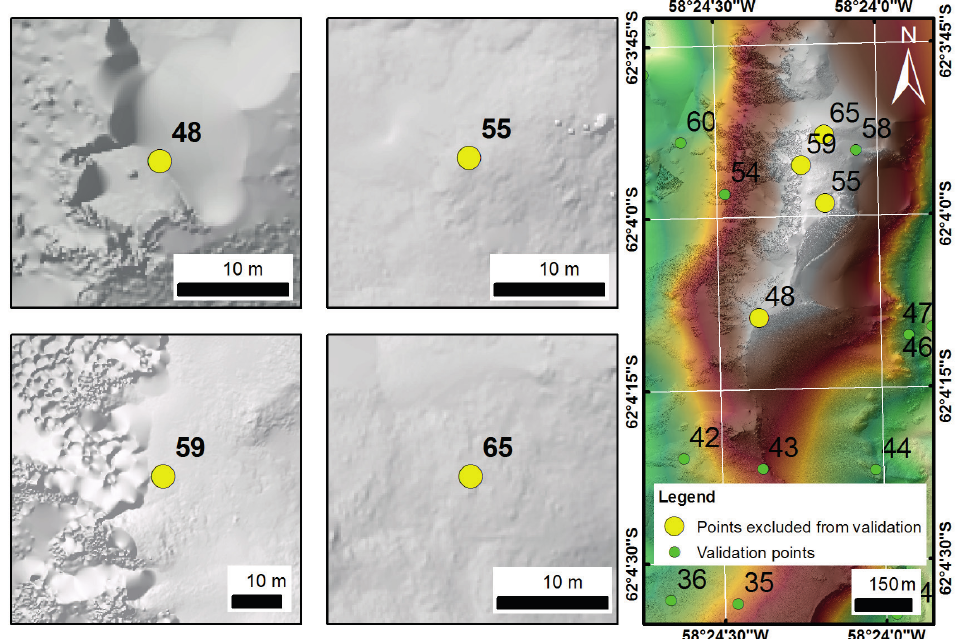
Figure 3 - Points considered as outliers for